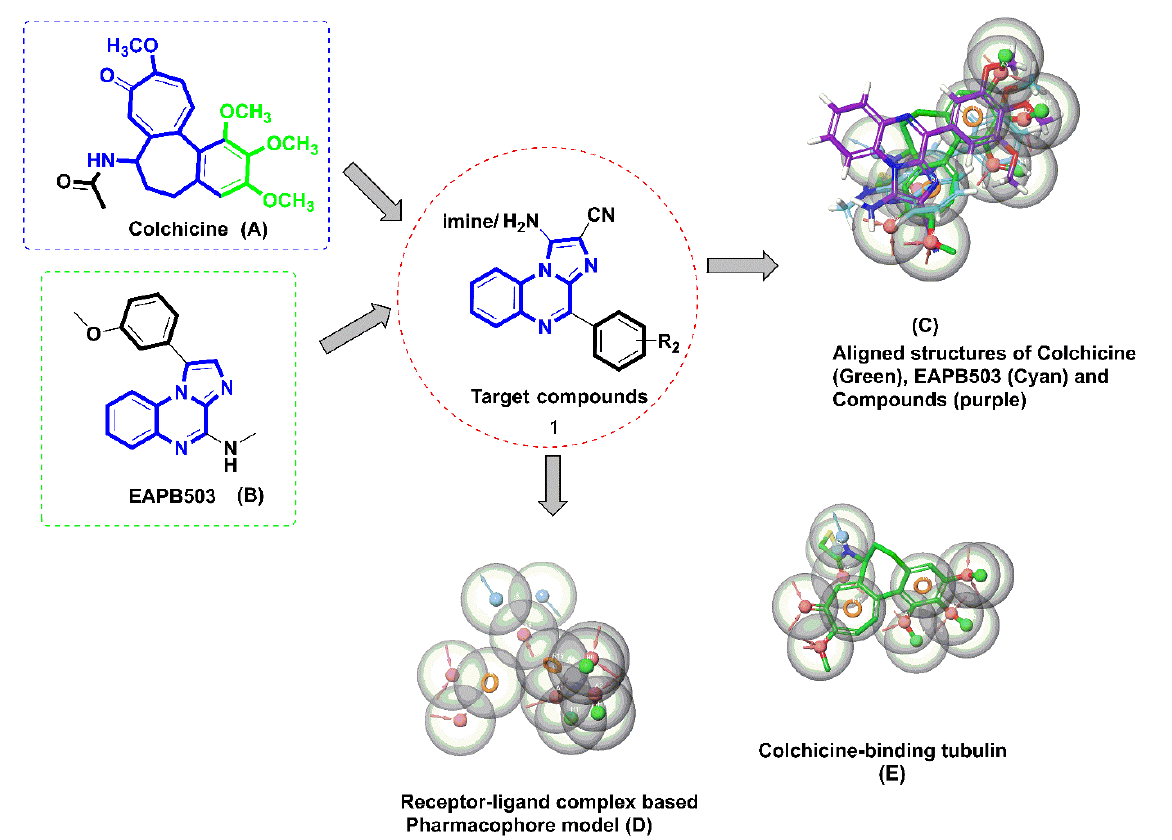
Figure 1. The rationale for selecting imidazo[1,2- a ]quinoxaline pharmacophore as an anticancer agent via tubulin inhibition. This highlights the basis of selection of target compound (1) considering the pharmacophoric feature of approved tubulin inhibitor Colchicine ( A ) and investigational tubulin inhibitor, EAPB503 ( B ). The alignment of all the pharmacophore from (1, A , B ) is represented ( C ) that reflects the aligned structures of Colchicine, EAPB503 and target compound. The critical overlapping was then refined that led to the generation of “Receptor-ligand complex” ( D ) using phase module. The obtained aligned pharmacophore was found to possess a hydrogen bond donor; a hydrogen bond acceptor; a hydrophobic group; an aromatic ring; a positively charged group; and a negatively charged group which is optimal for Colchicine binding at the CBS ( E ).